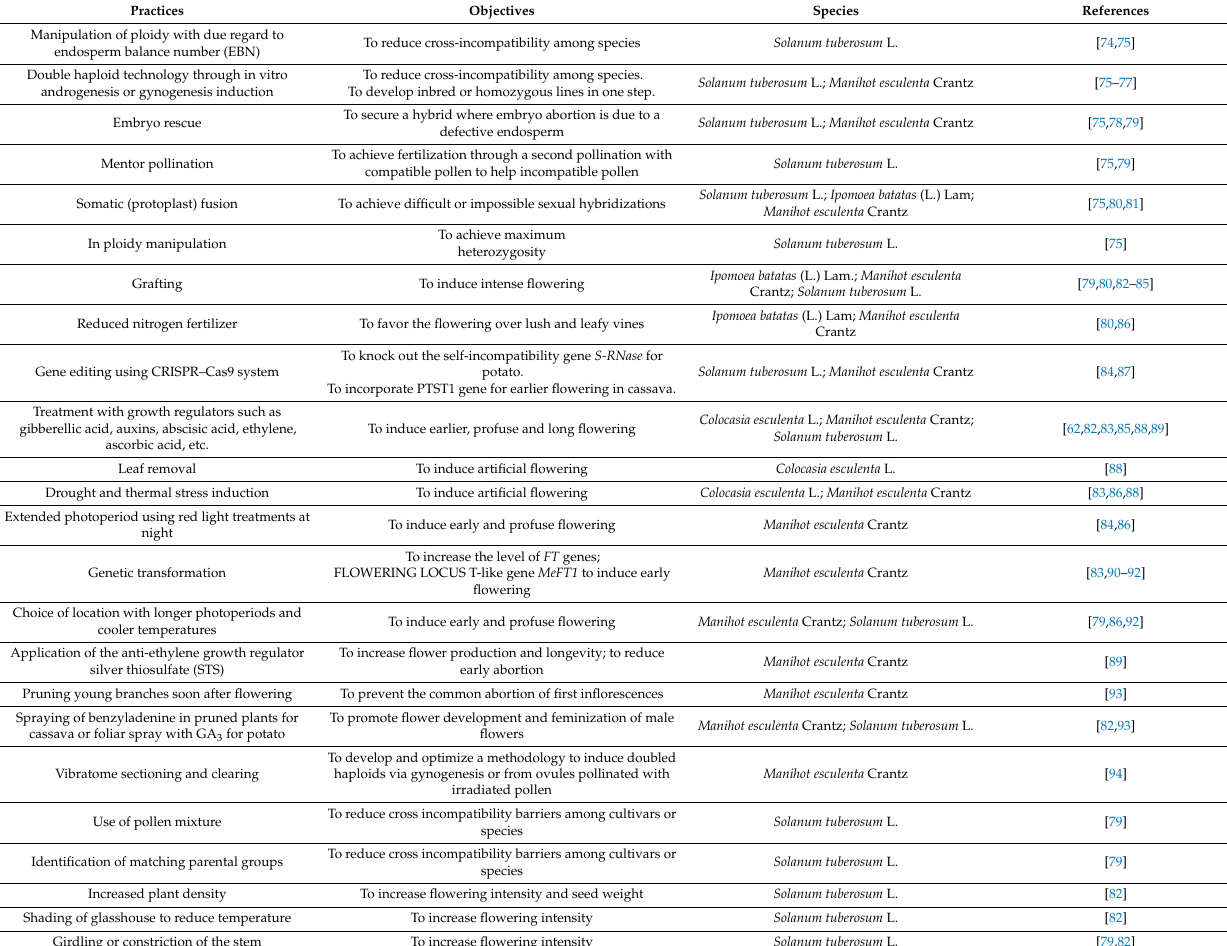
Table 3. Manipulation of flowering and pollination in root and tuber crops with potential application in